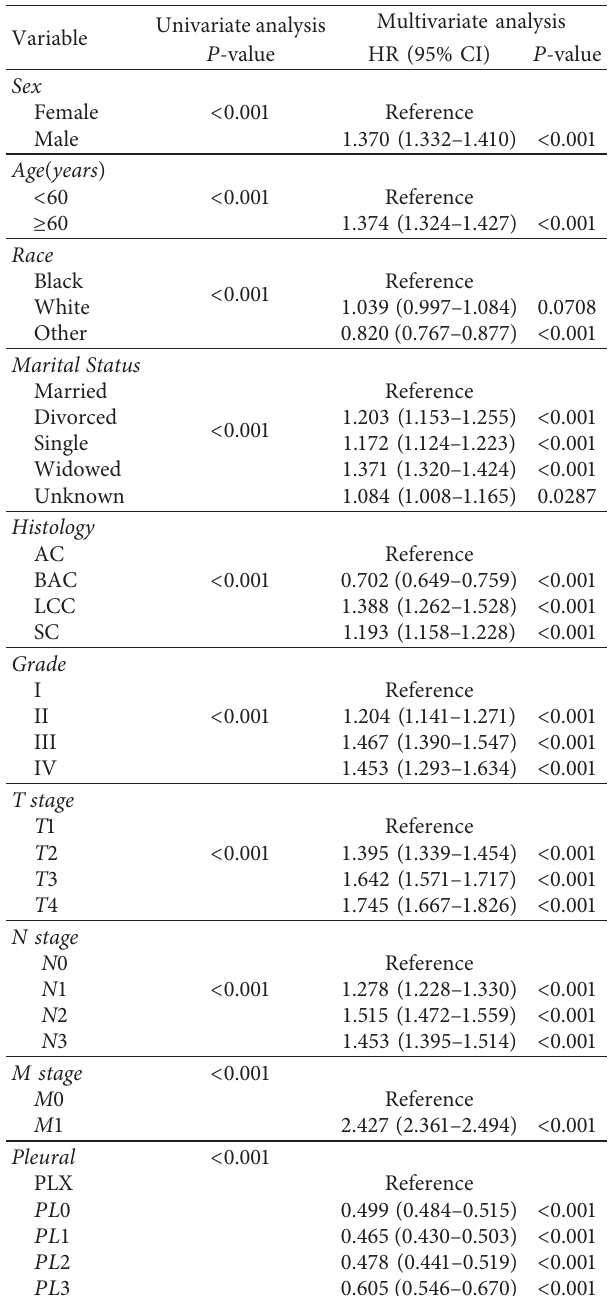
Table 2: Univariate and multivariate Cox regression analysis of the training